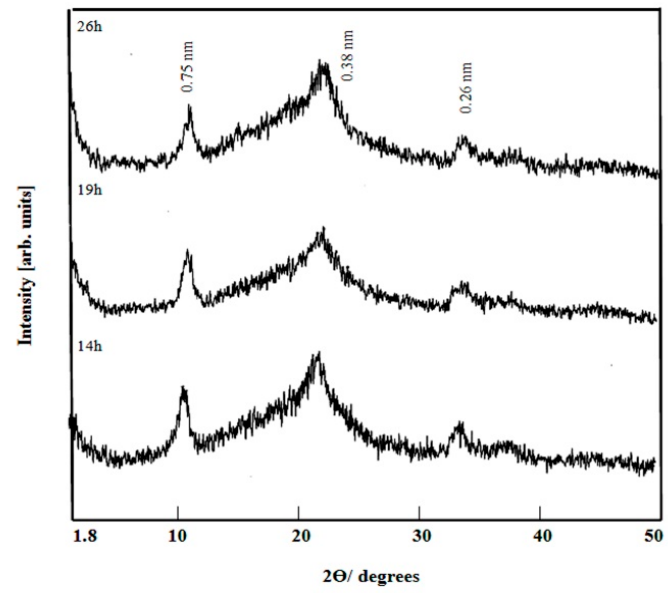
Figure 2. X-ray di ff raction of Ni-Ti-4 LDHs at di ff erent reaction times and dried at room temperature. Figure 2. X-ray diffraction of Ni-Ti-4 LDHs at different reaction times and dried at room temperature.